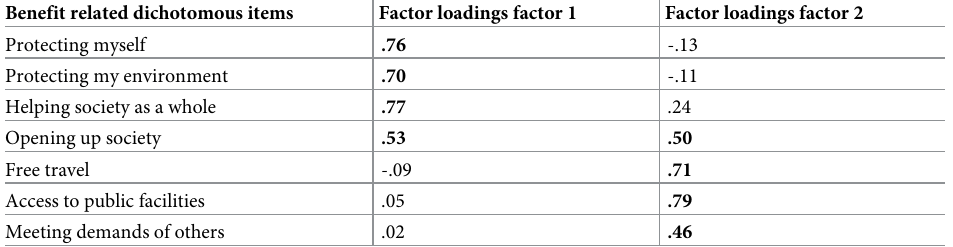
Table 2. Factor loadings of benefit related items on underlying constructs with an eigenvalue of > 1 as determined by latent class analysis.